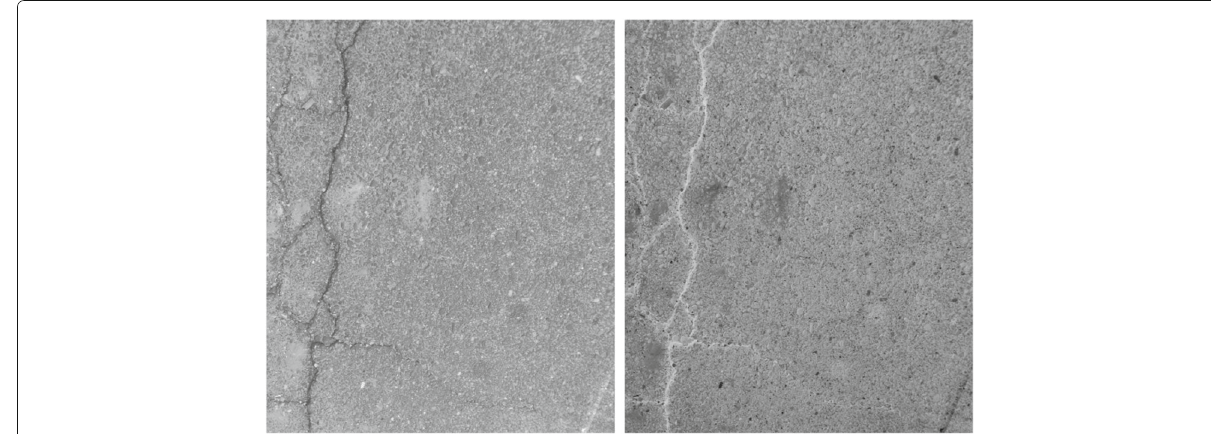
Fig. 3 Original gray scale image of a crack ( left ) and negative of the original image ( right )